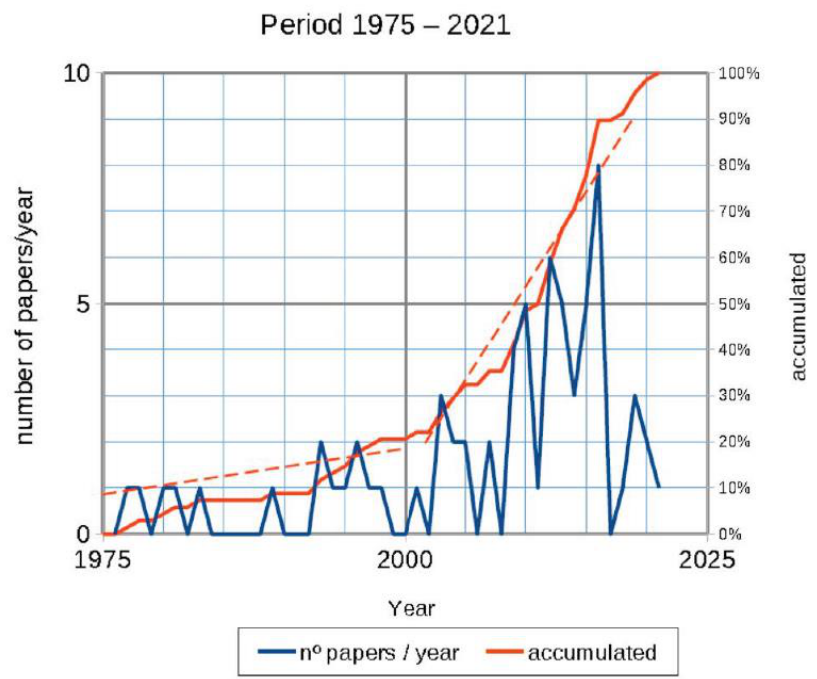
Figure 5. The number of papers/year (in blue) published related to load-holding valve issues shows an accumulated behavior (in red) with a tendency of 80% in the last 20 years.